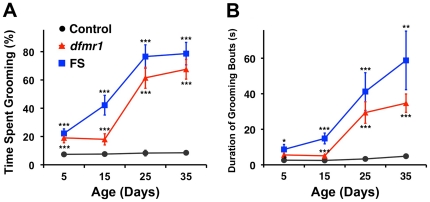

dfmr1 mutant flies exhibit excessive grooming that increases with age.(A). At 5 days old, dfmr1 and FS flies groom significantly more than control flies. Grooming increases with age in mutant flies; control flies show consistent levels of grooming at all ages tested. (B). The average duration of grooming bouts in mutant flies follows a similar trend to the total time spent grooming (A). In contrast, control flies show little change in the duration of grooming bouts from 5 to 35 days of age. Data are represented as the mean percentage of time single flies spend grooming during a 5 min period (Mean +/- SEM; n = 10–15 flies for each genotype at each time point). For all data, *p<0.05, **p<0.01, and ***p<0.001.